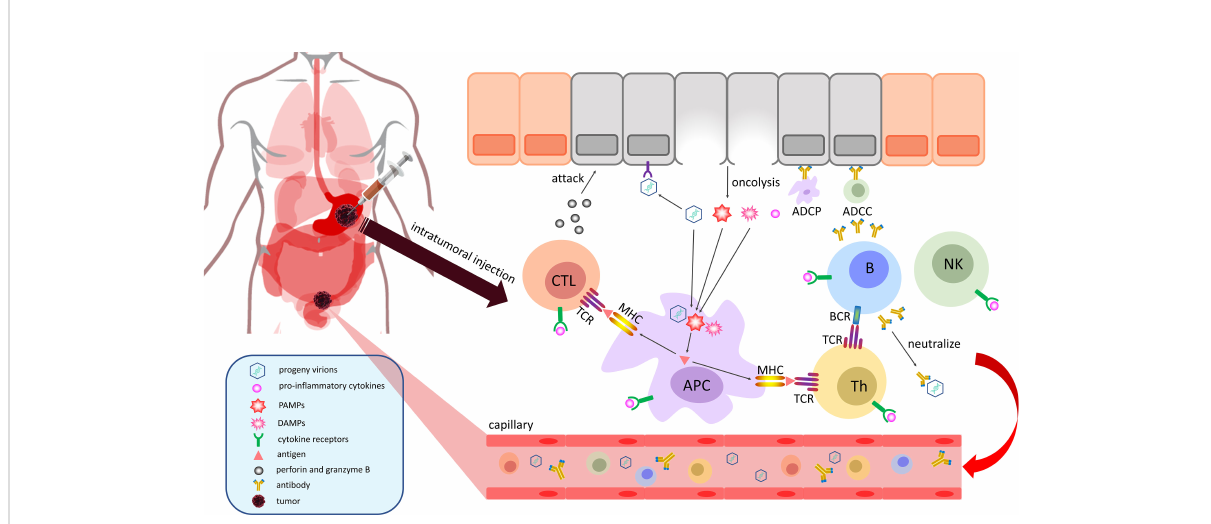
FIGURE 2 OVs can stimulate a systemic adaptive antitumor immune response. Cancer cells are lysed by mature OVs to release viral progeny, TAAs, PAMPs and DAMPs into the TME. Among them, progeny virions will ceaselessly infect the surrounding cancer cells to establish a cascade ampli fi cation reaction to eliminate malignancy. In fi ltrative APCs can swallow and process TAAs, PAMPs, and DAMPs to present neoantigens by MHC molecules for the activation of immune cells. The sensitized CTLs attack the identi fi ed cancer cells by releasing perforin and granzyme B, and the activated Th cells can stimulate B cells to promote their activation and secrete neutralizing antibodies, which can mark malignant cells for ADCC by NK cells or ADCP by macrophages. Finally, immune effector cells, immune effector molecules and progeny virions will travel through the body with the blood to initiate a systemic adaptive antitumor immune response. APC, antigen-presenting cell; NK, natural killer cell; MHC, major histocompatibility complex molecule; CTL, cytotoxic T lymphocyte; Th, T helper cell; ADCC, antibody-dependent cellular cytotoxicity; ADCP, antibody-dependent cellular phagocytosis; PAMPs, pathogen-associated molecular patterns; DAMPs, damage-associated molecular patterns; TCR, T-cell receptor; BCR, B-cell receptor; TAA, tumor-associated